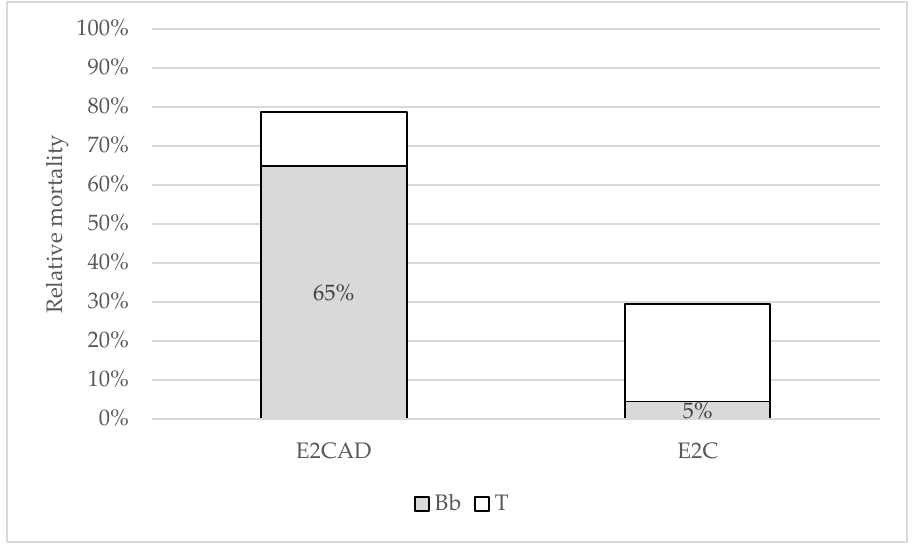
Figure 6. Histogram of total (T) B. bassiana (Bb) attributed mortality for treatments in experiment two. Relative rates for treated group (E2CAD) were Abbott corrected for the mortality observed in the control group (E2C).